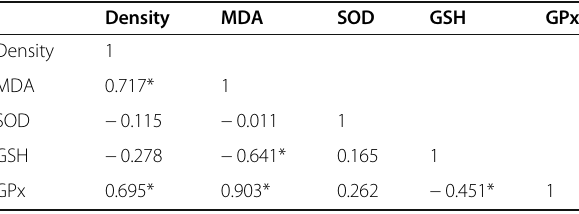
Table 5 Pearson correlation coefficient between parasite density, lipid peroxidation, and anti-oxidants in malaria parasite- infected patients